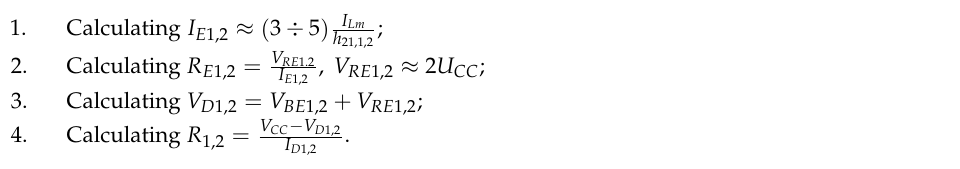
Algorithm 2: Design of intermediate